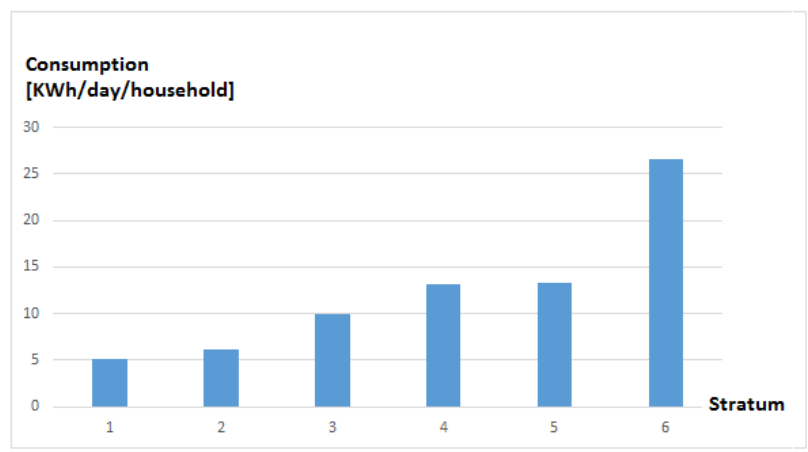
Figure 1. Daily consumption average per stratum.